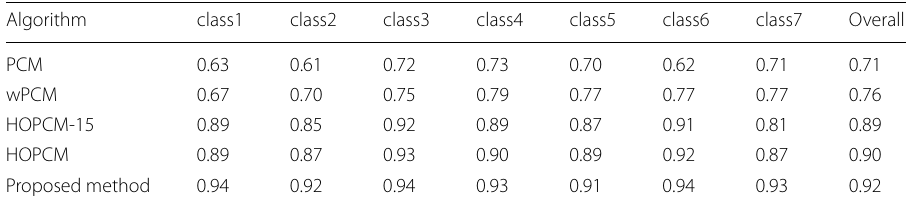
Table 5 Results of clustering quality on the Caltech101 dataset (ARI Score)